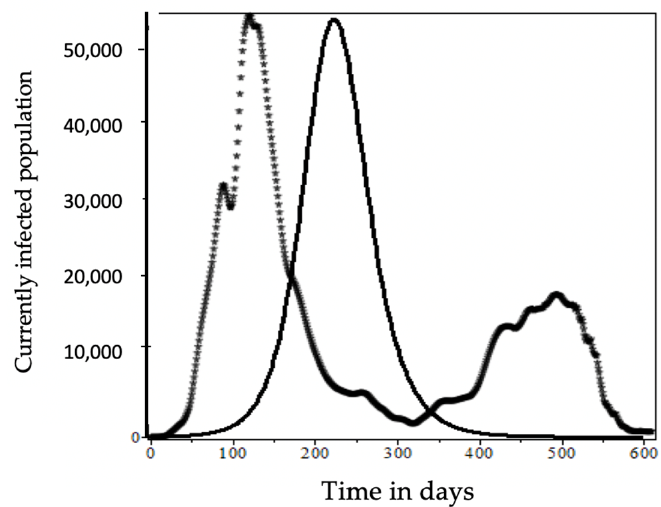
Figure 9. Current active cases in Saudi Arabia. Asterisks represent the real data, and the continuous line ( Y ( t )) represents the model prediction with a constant transmission rate for the symptomatic population.